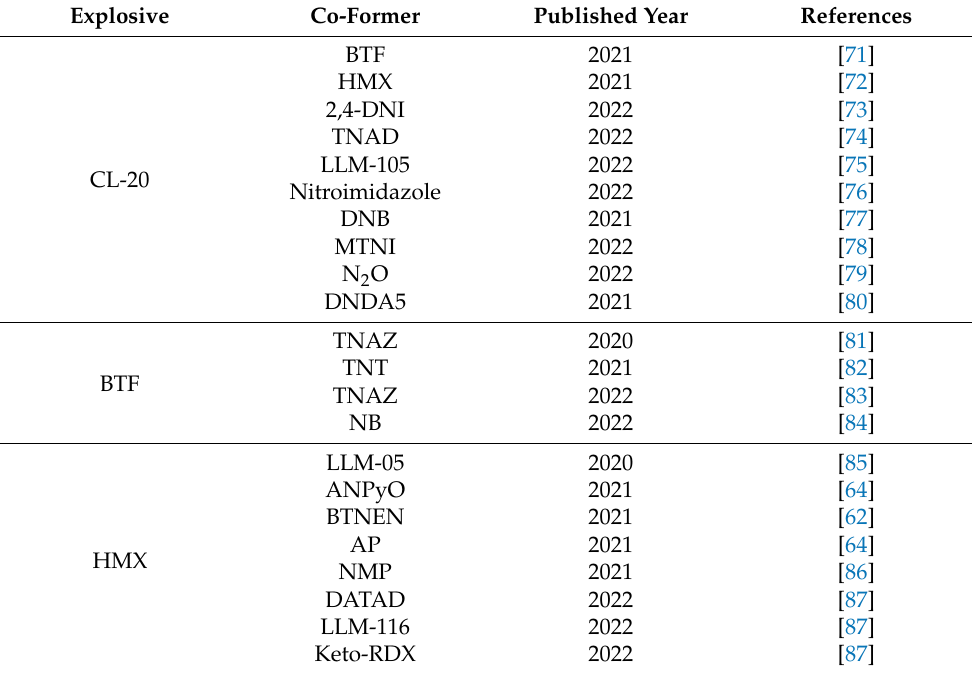
Table 2. Newly published cocrystal based on CL-20, BTF, and HMX explosives.